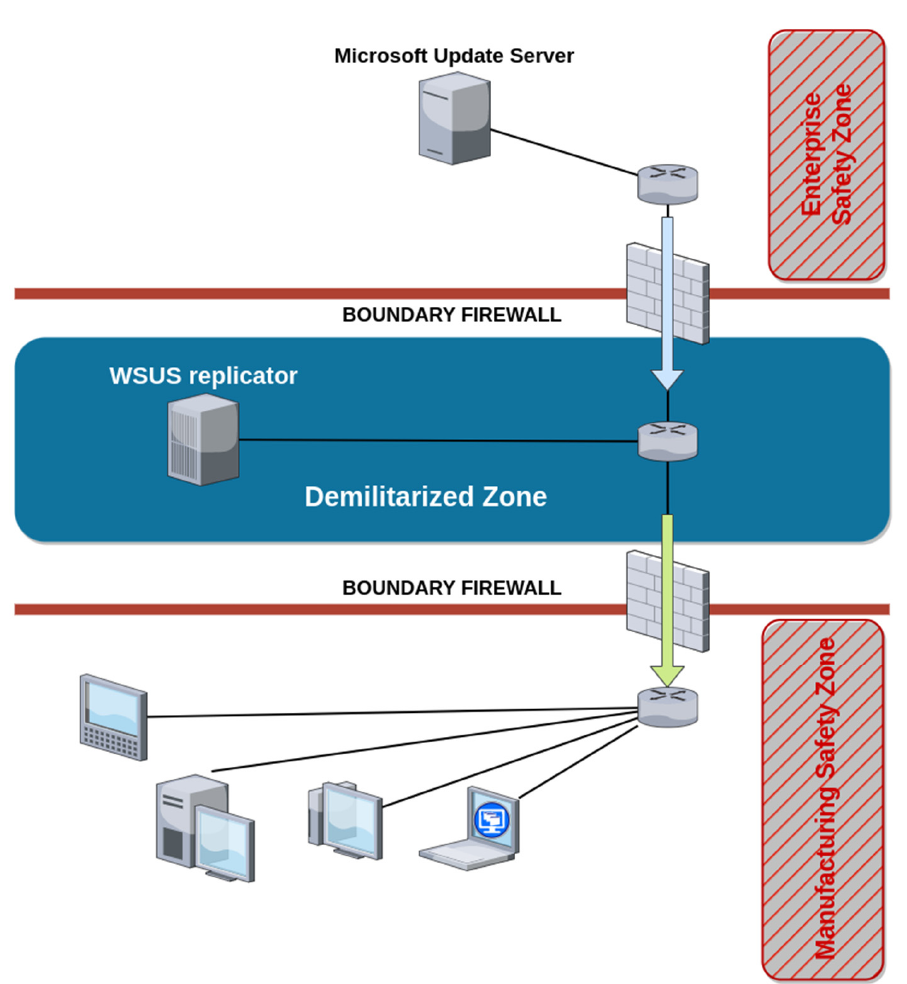
Figure 18. Implementation of WSUS according to the SF layers.